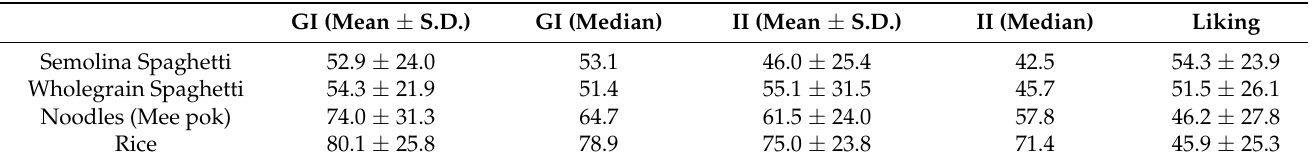
Table 4. Glycaemic Index (GI), Insulinaemic Index (II) and overall liking of the four treatment meals (mean ± standard deviation). GI (Mean ±